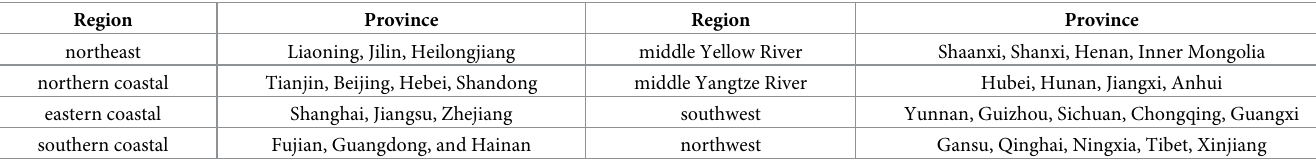
Table 1. Eight regions and 31